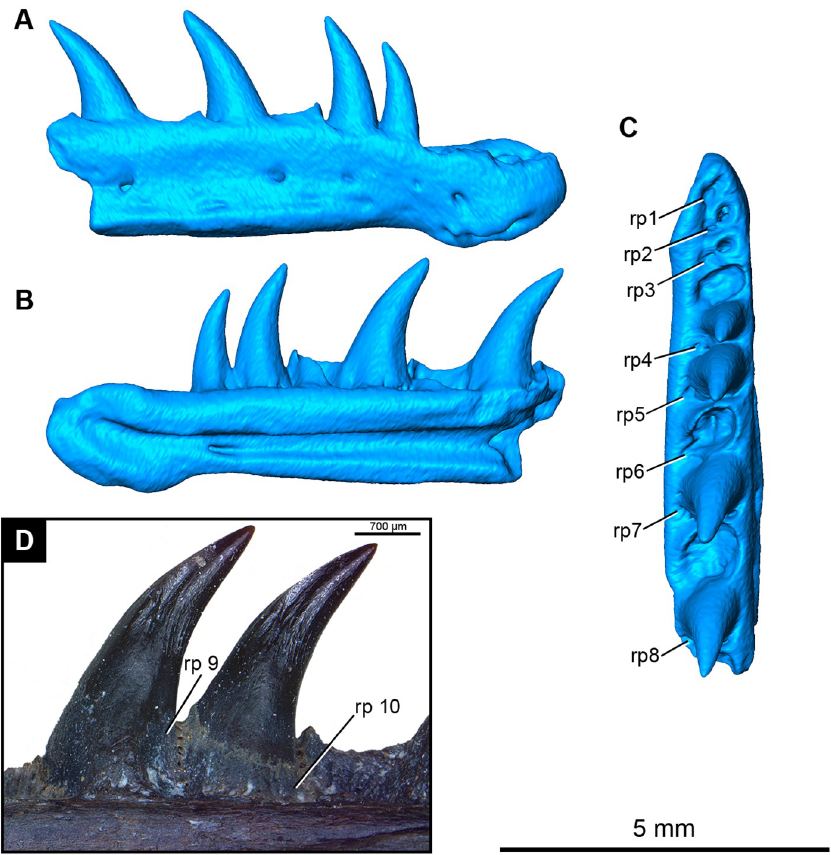
Fig 8. Rendering and photograph of Maiothisavros dianeae right dentary. ROMVP 87367, right dentary in (A) labial, (B) lingual, (C) occlusal, and (D) ROMVP 87368 photograph of tooth positions 8 and 9 in lingual view showing resorption pits. Abbreviation: rp, resorption